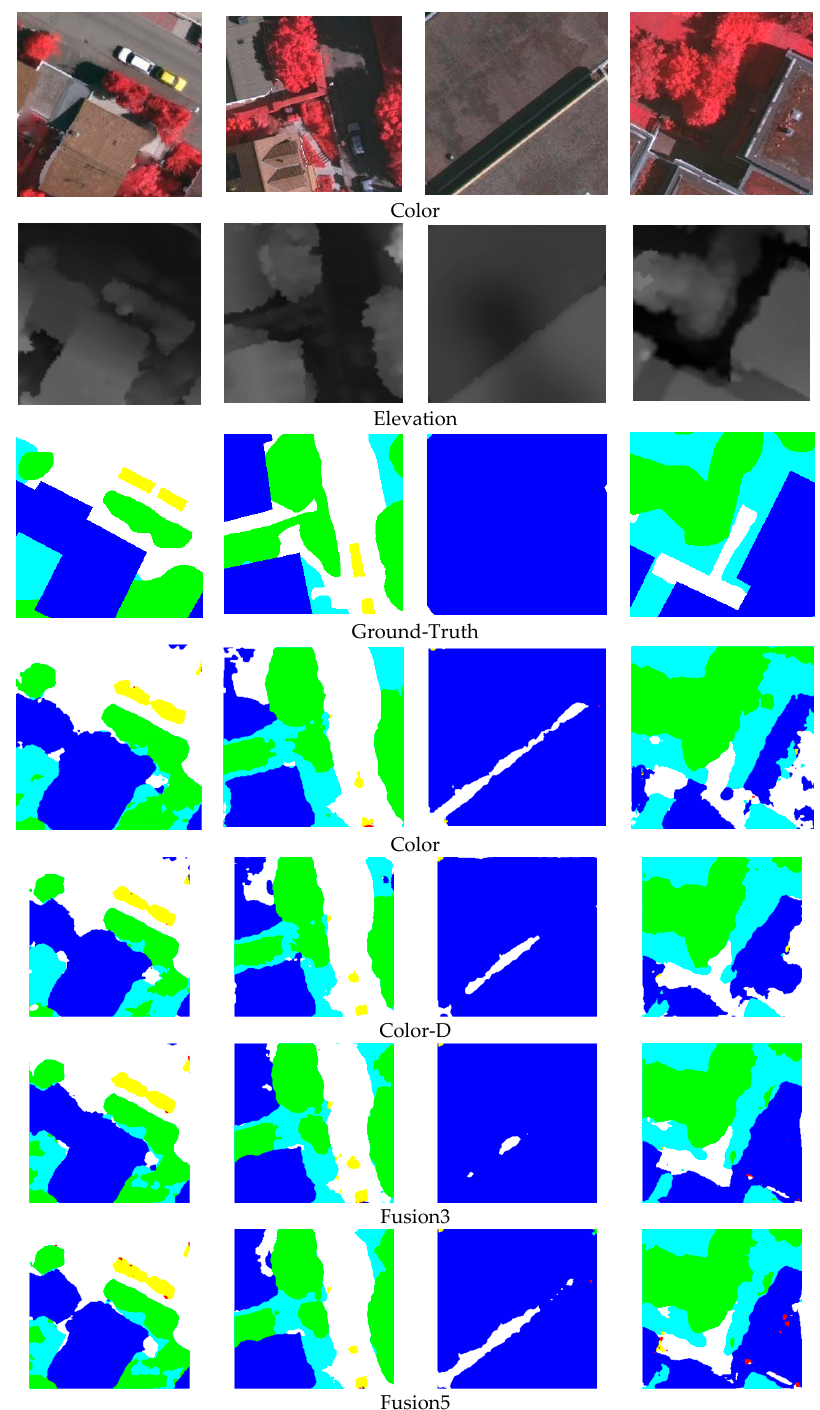
Figure 6. Qualitative segmentation results. The first three rows give the input data color, elevation and ground-truth. The following rows present the segmentation results of different models. The last two rows show our fusion model results. The Fusion3 model obtains the best accuracy for the Vaihingen